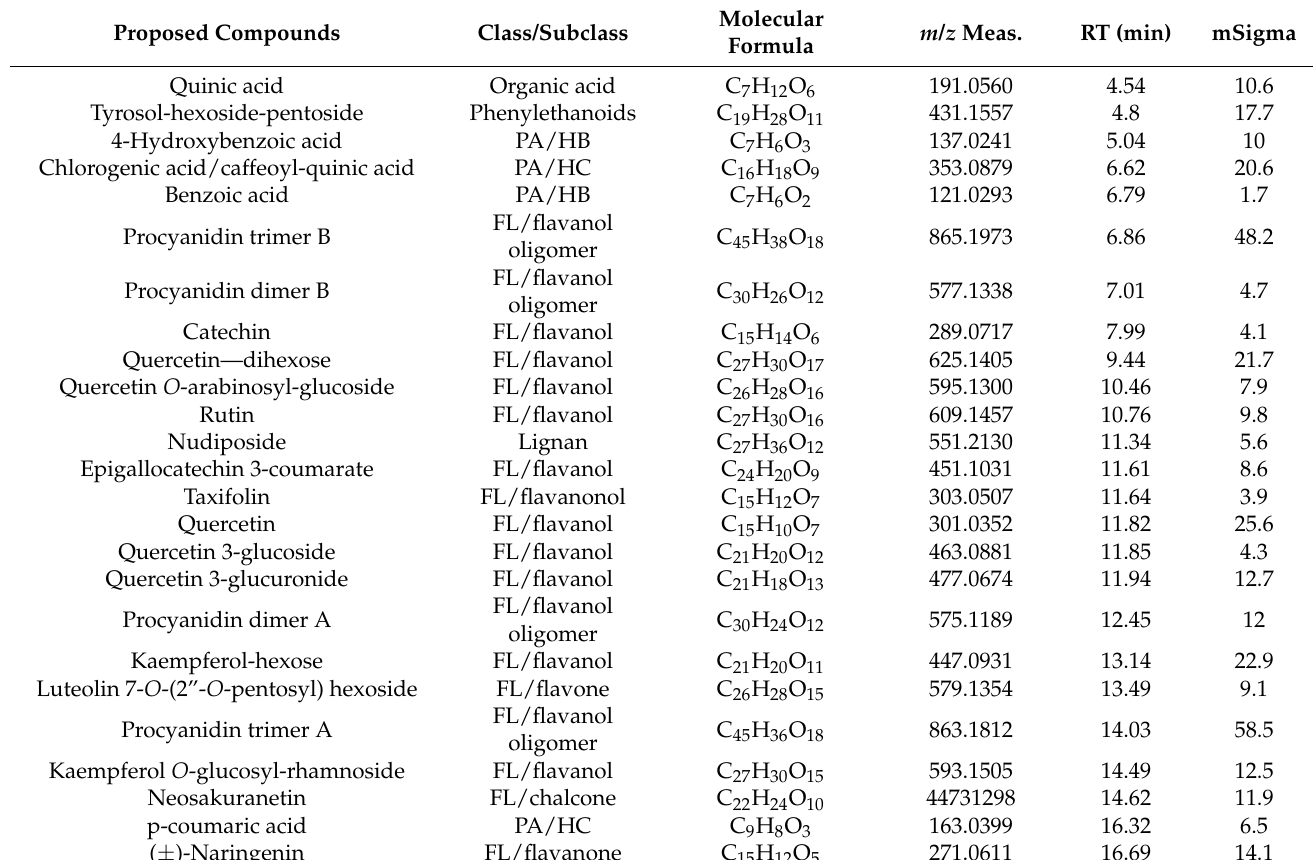
Table 5. Tentative identification of phenolic compounds in AP